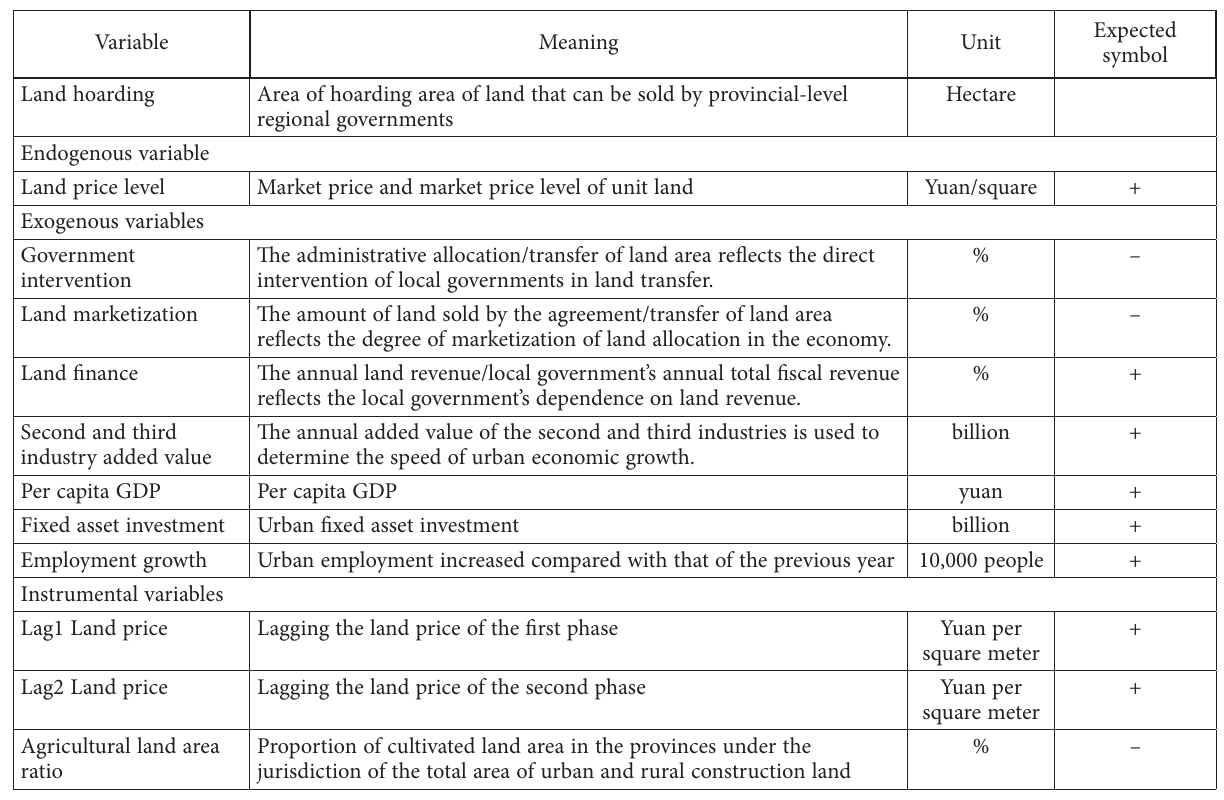
Table 1. Variable measurement and expected